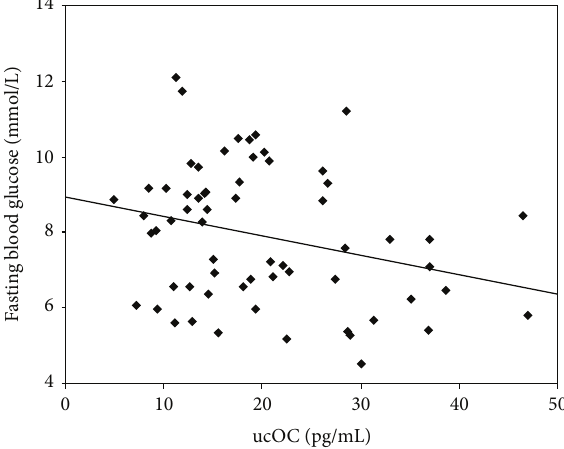
Figure 2: Negative correlation between ucOC and fasting blood glucose ( 𝑟 = −0.278 , 𝑃 = 0.027